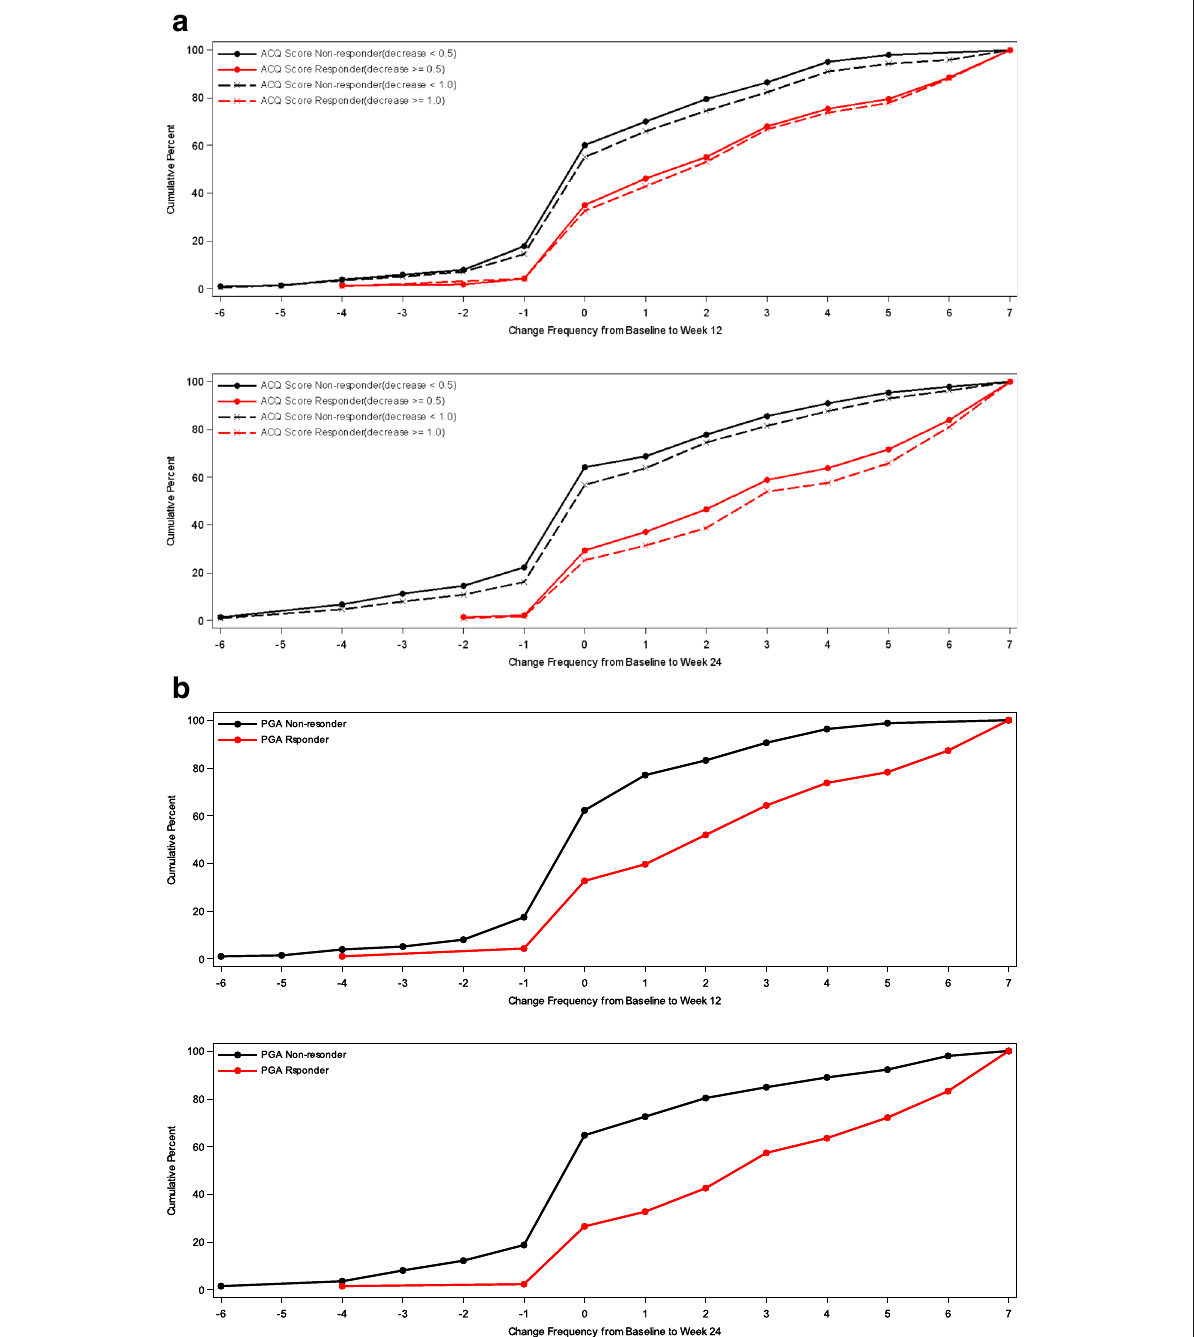
Fig. 4 a Cumulative Distribution Curves for ASD Minimal Symptom Days-1 by ACQ Based Responder Criteria PRO analysis set includes all subjects who are enrolled and have Asthma Symptom Diary measurement at baseline b Cumulative Distribution Curves for ASD Minimal Symptom Days-1 by PGA Based Responder Criteria. PRO analysis set includes all subjects who are enrolled and have Asthma Symptom Diary measurement at baseline and at 12 weeks or 24